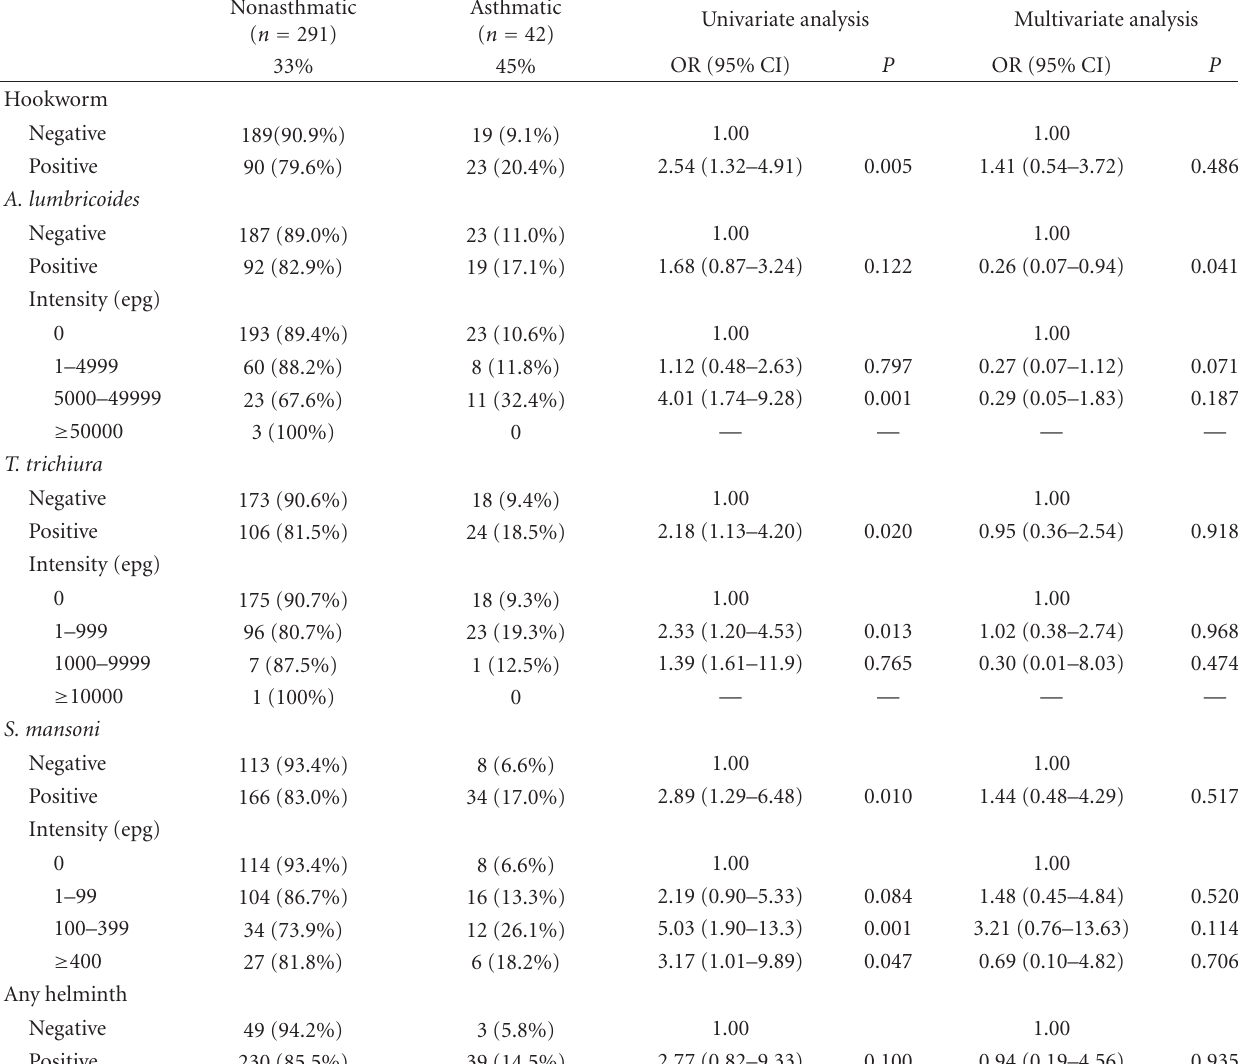
Table 3: Univariate and multivariate analysis of the association between asthma and helminth infections. Asthmatic Nonasthmatic Univariate analysis Multivariate ( n = 42) ( n = 291)